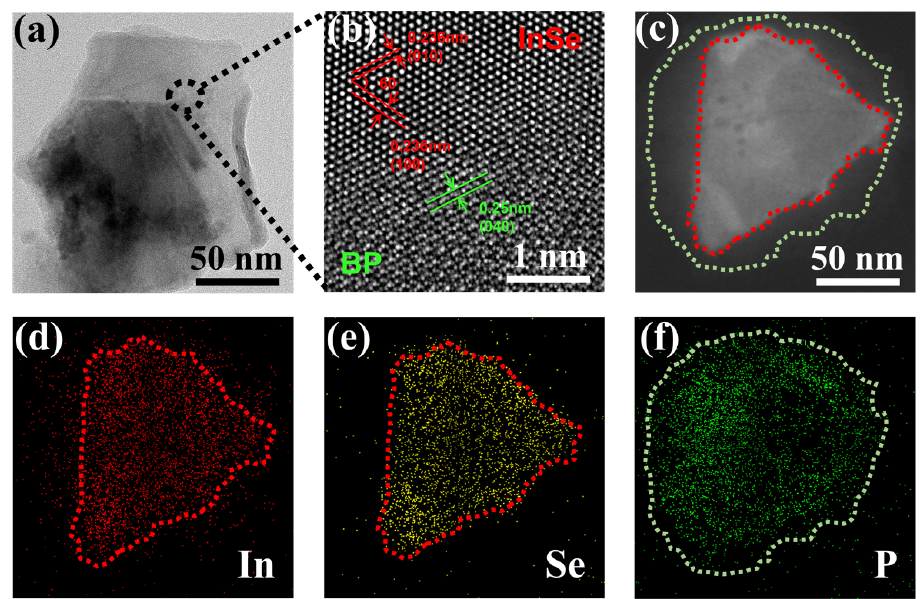
Figure 2. Morphology and characterization of the prepared 2D BP/InSe heterostructure. ( a ) TEM image. ( b ) HRTEM image. ( c – f ) Elemental mapping image.